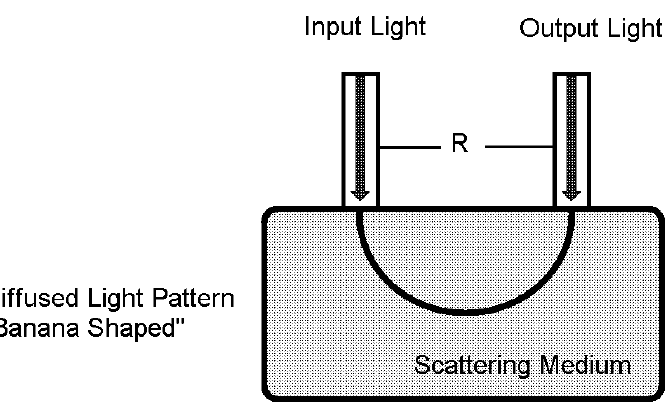
Figure 2. Banana-shaped envelope used in the Beer–Lambert law, where light detector and emitter are aligned on the same side.